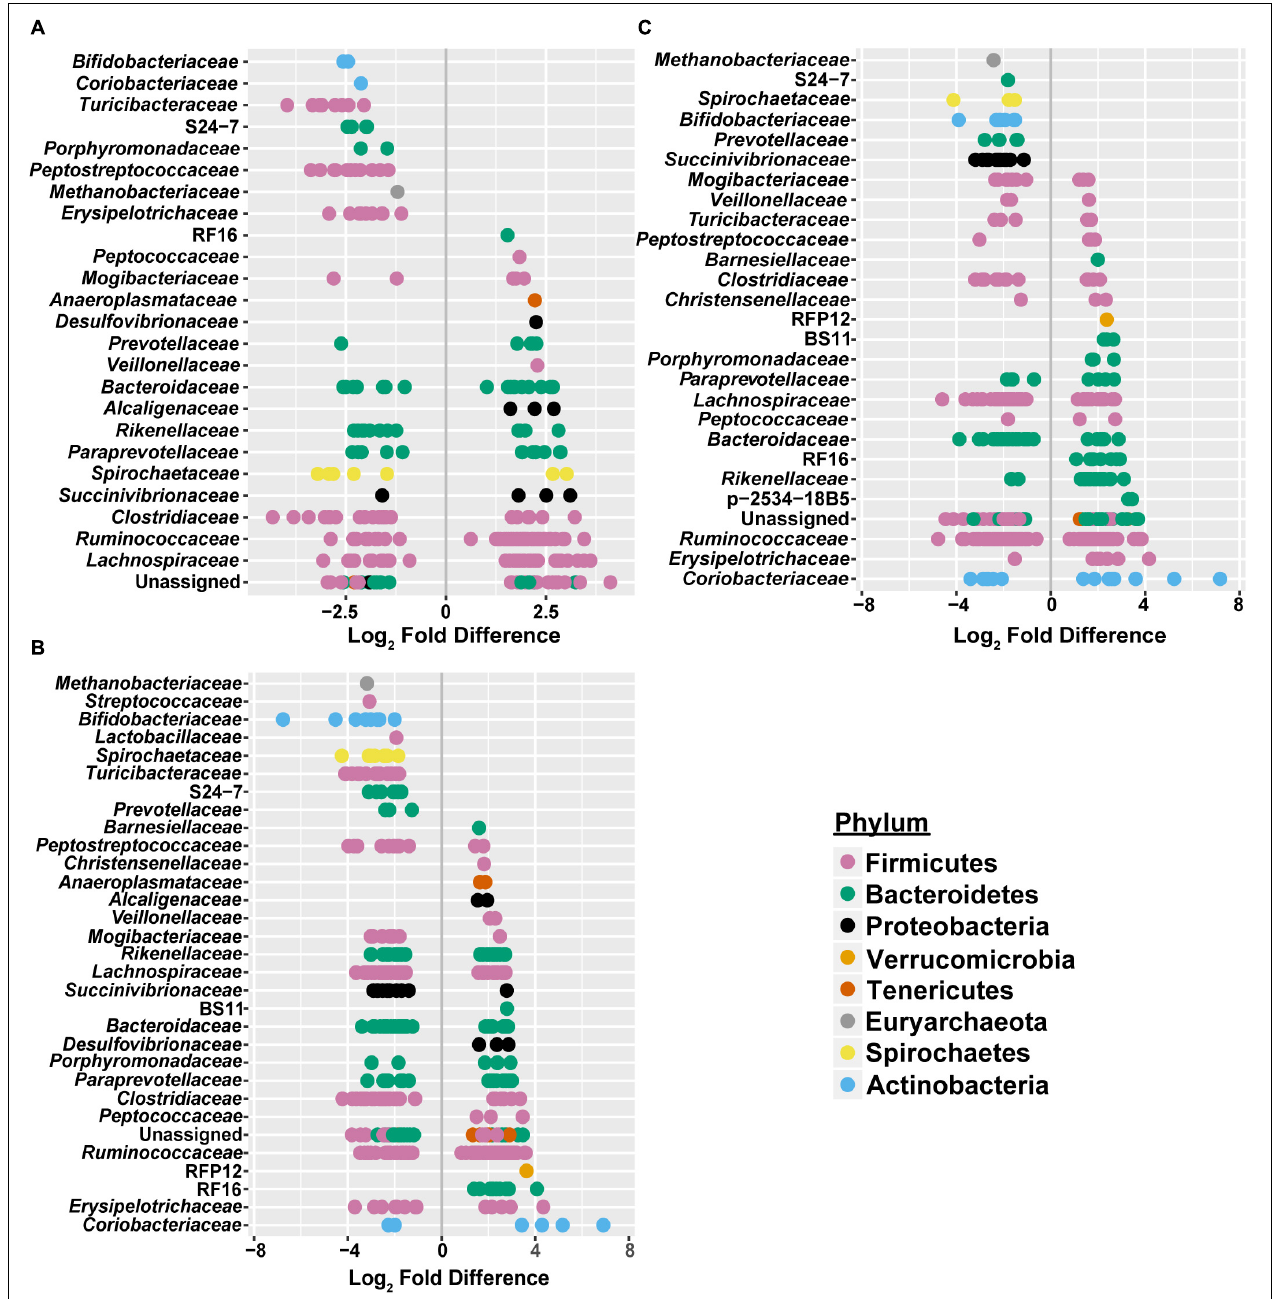
FIGURE 5 | Significant log2 fold-differences of bacterial families’ abundance between (A) freestall and drylots (B) pasture and freestalls and (C) pasture and drylots are presented. Each point is colored by its assigned phyla and represents an OTU that showed a significant difference in abundance between the two housing types compared. Negative values denote a log2 fold reduction of that OTU in the first housing type compared to the second. Similarly, positive values denote log2 fold increases of an OTU in the first housing type compared to the second. Comparisons of between housing types shared log2 fold differences in many of the same families. Adjusted p ≤ 0.01 considered